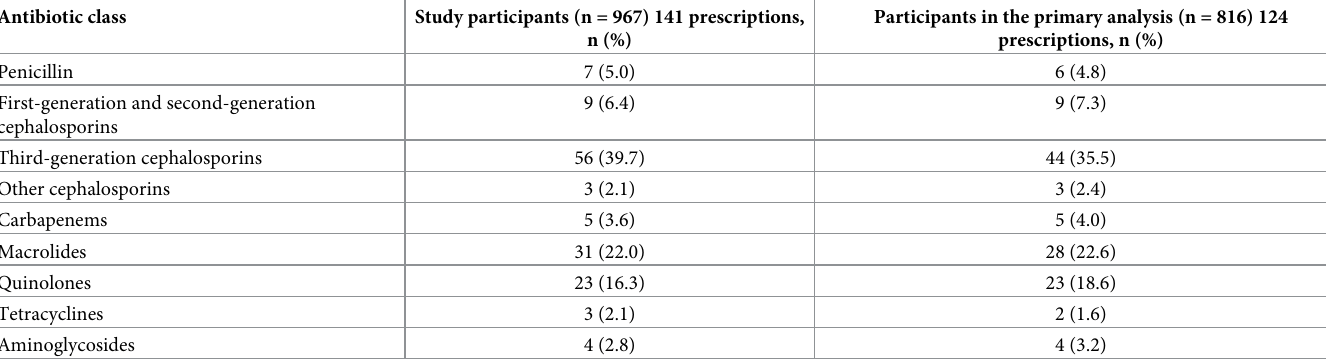
Table 2. Prescribed antibiotics according to antibiotic